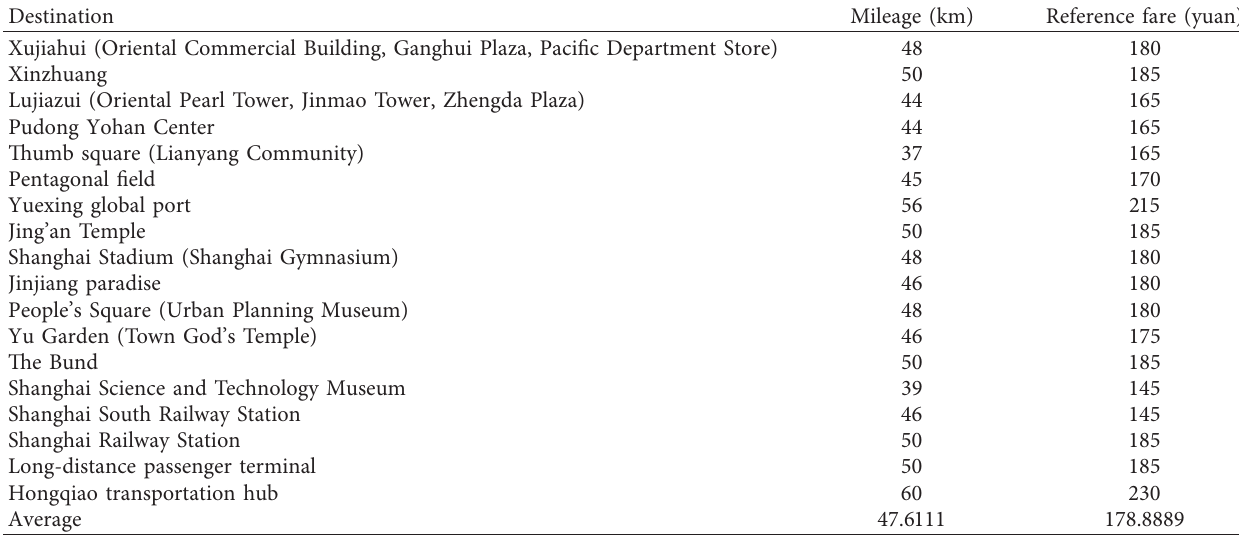
Table 15: Taxi mileage and reference price from an airport to urban landmark.